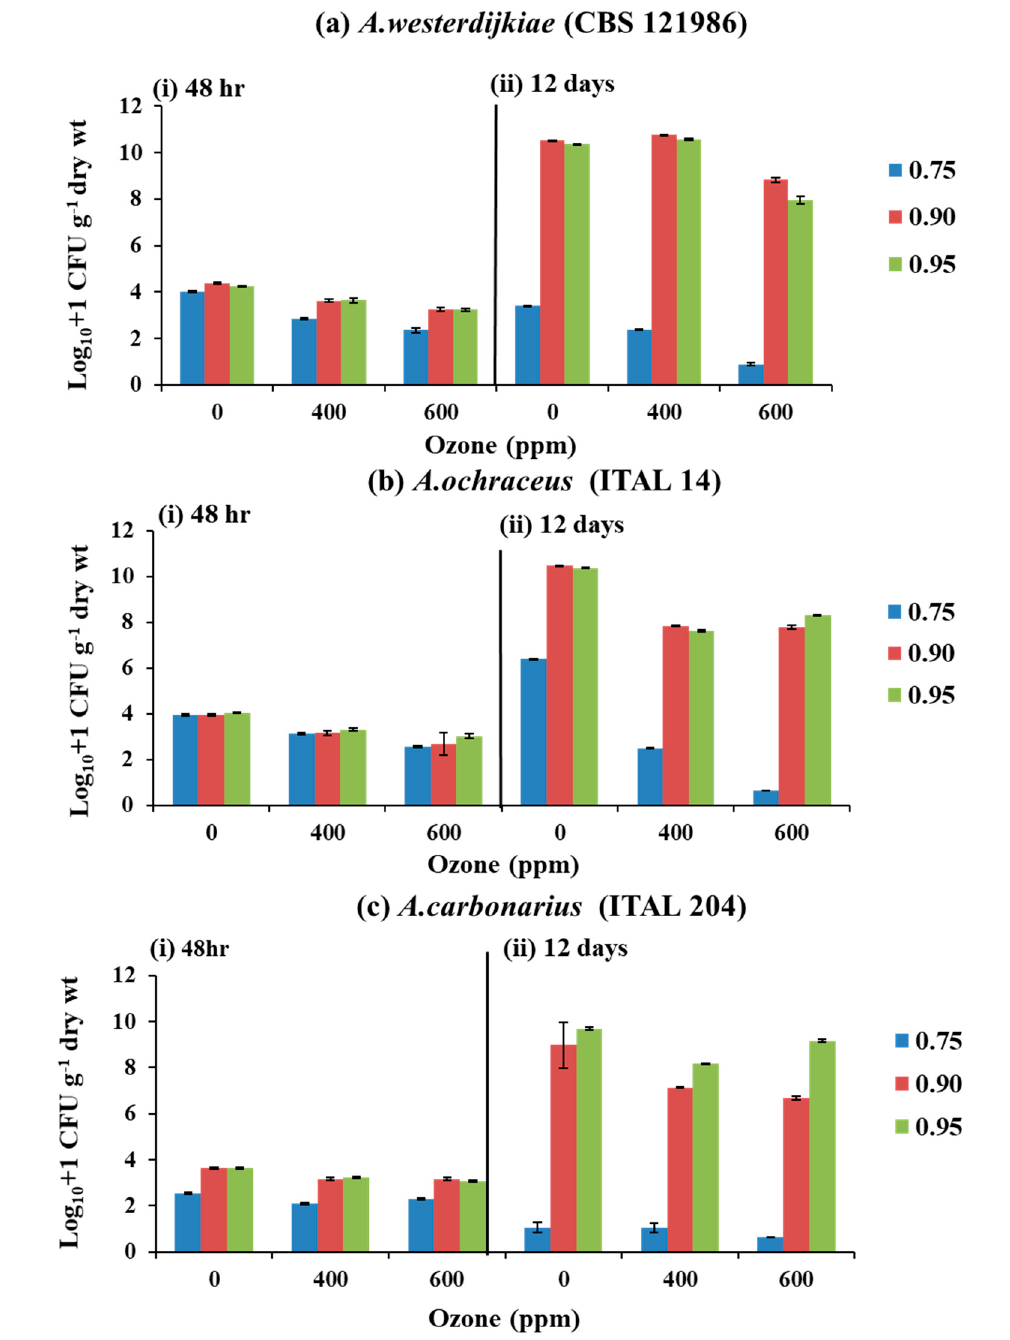
Figure 1. Effect of 0, 400, and 600 ppm O 3 exposure (60 min; 6 L min − 1 ) on the log 10 +1 populations of ( a ) A. westerdijkiae , ( b ) A. ochraceus , and ( c ) A. carbonarius pre-inoculated on irradiated coffee beans adjusted to 0.75, 0.90, and 0.95 a w , compared to the control (untreated, 0 ppm); (i) 48 h after exposure and (ii) after 12 days storage at 30 °C. Vertical bars indicate the standard error of the means.